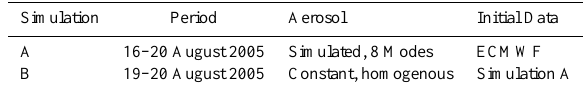
Table 1. Simulation description.